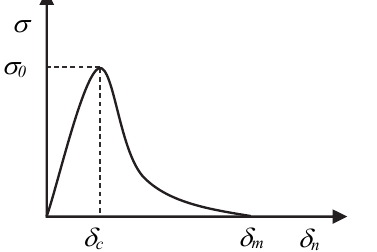
Figure 3: Exponential traction-separation relationship for mode I loading